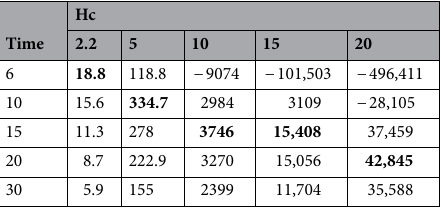
Table 8. Interaction effect of charging/discharging time and Hc. Significant values are in bold.